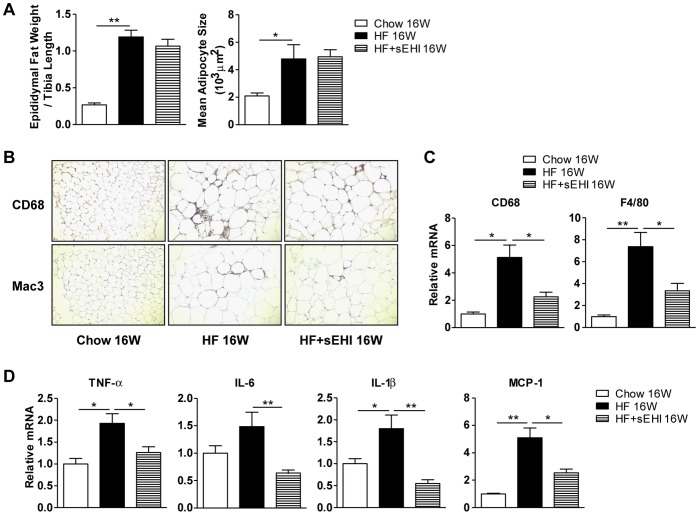
sEH inhibition attenuated 16-week HF-diet–induced macrophage infiltration in adipose tissue.(A) Ratio of epididymal fat weight compared to tibia length, and mean size of adiopocytes in epididymal fat of 16-week HF-diet–fed mice with or without full-term sEHI. (B) Immnohistochemical staining for macrophage markers CD68 and Mac3 in epididymal fat. (C) mRNA levels of CD68 and F4/80 in epididymal adipose tissue. (D) mRNA levels of TNF-α, IL-6, IL-1β and MCP-1 in epididymal adipose tissue. Data are mean ± SEM. (* P<0.05, ** P<0.01).